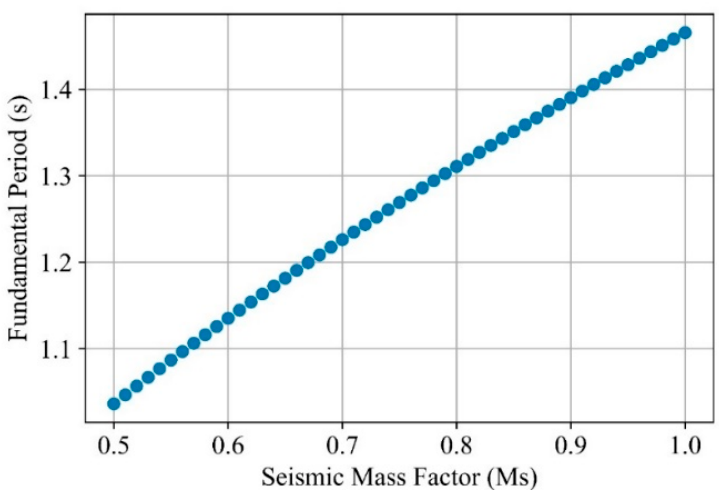
Figure 14. Variation of seismic mass factor (Ms) vs. fundamental period.